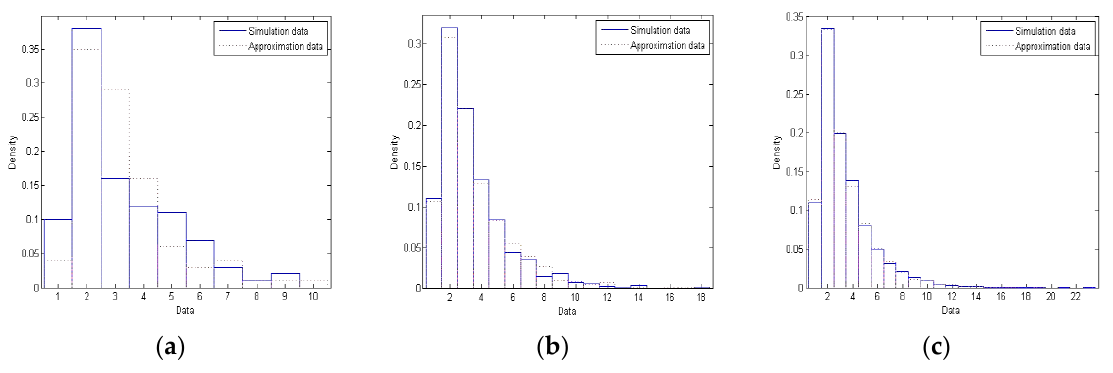
Figure 1. Probability histograms for networks with Table 2. ( a ) 100 nodes; ( b ) 1000 nodes; ( c ) 10,000 nodes.